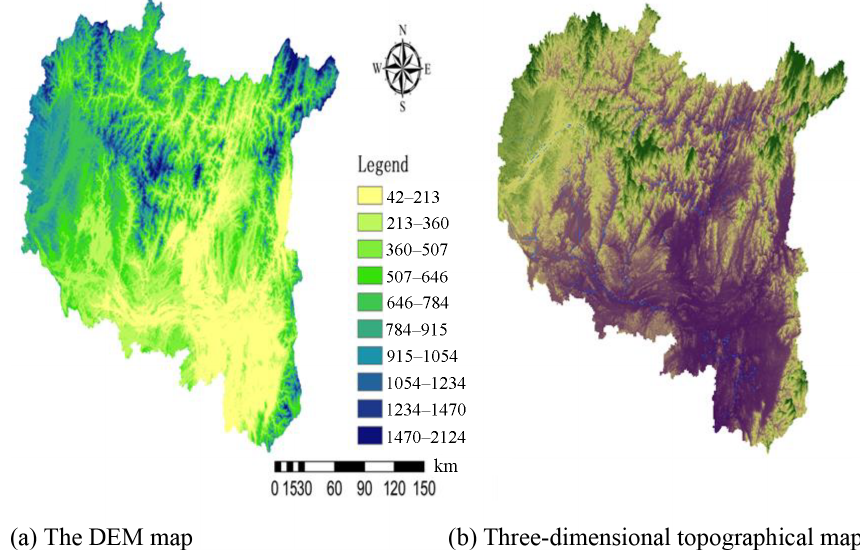
Figure 2. The DEM and three-dimensional topographical map of the LKRB.